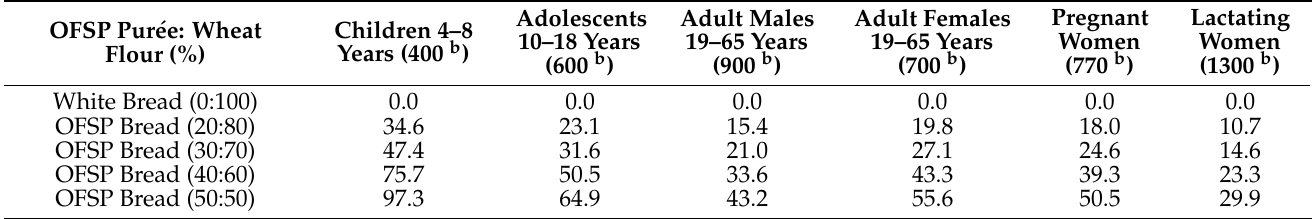
Table 4. Percentage contribution of vitamin A RDA in different groups by OFSP pur é e–wheat flour composite bread a .